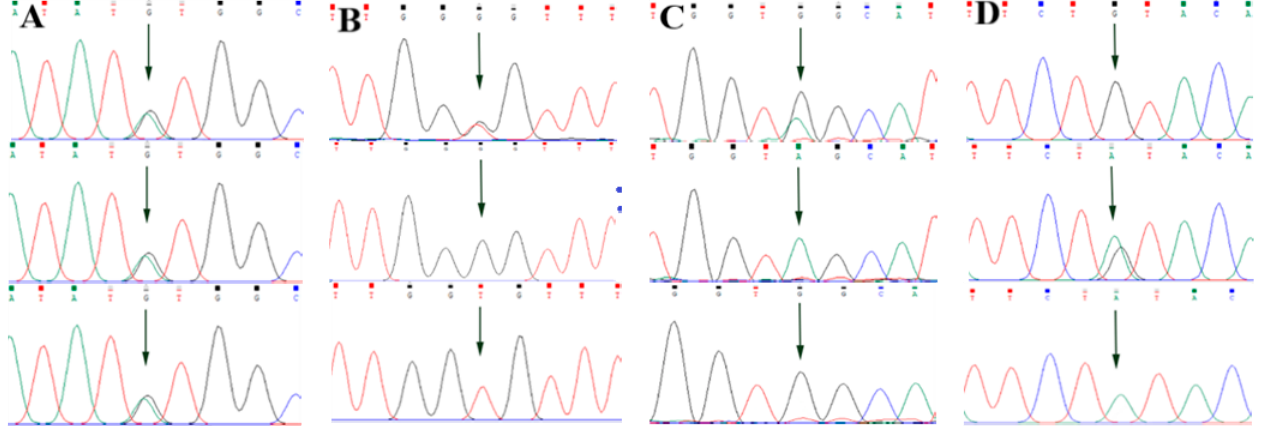
Figure 1. GO annotation and KEGG pathway enrichment of ABCG2 , CD44 and SPP1 genes. ( A ) GO annotation results of three genes in BP, CC and MF. ( B ) Distribution of enriched KEGG pathway.